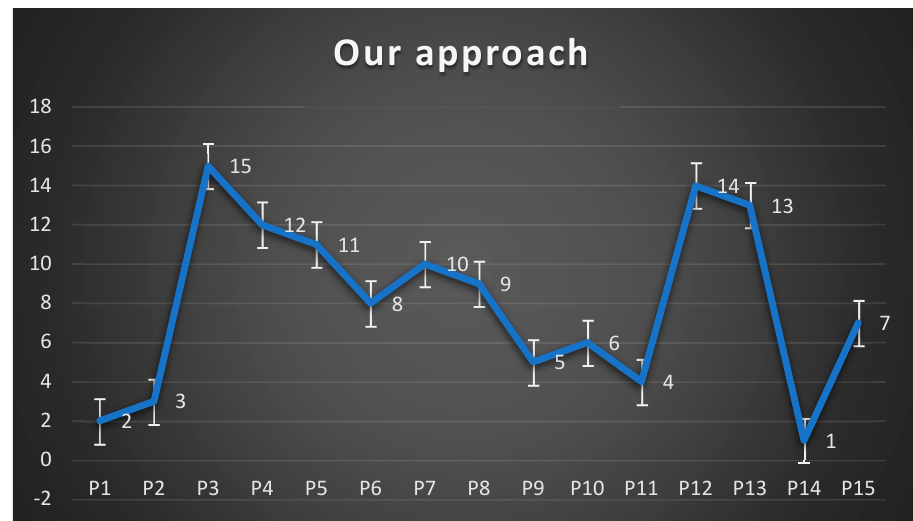
Figure 7. Ranking of PPP projects. Source: Heydari et al. [7].